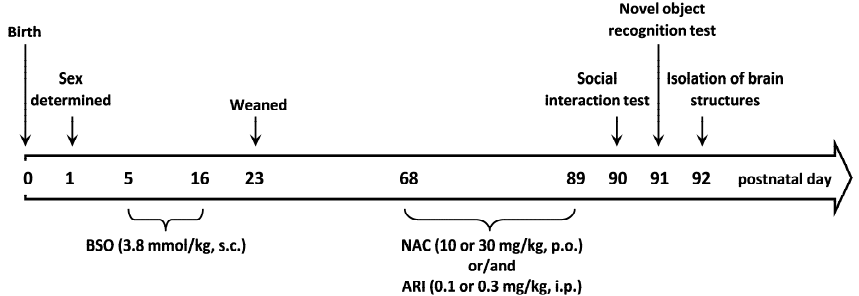
Figure 5. The diagram illustrating the timeline of the